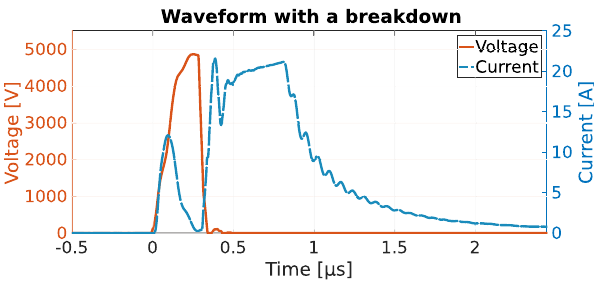
FIG. 5. Conditioning and first flat mode runs of soft Cu Helsinki visualized. The graph shows evolution of the electric field and number of breakdowns as a function on pulses. The conditioning part, as well as the different flat mode runs are separated by red dashed